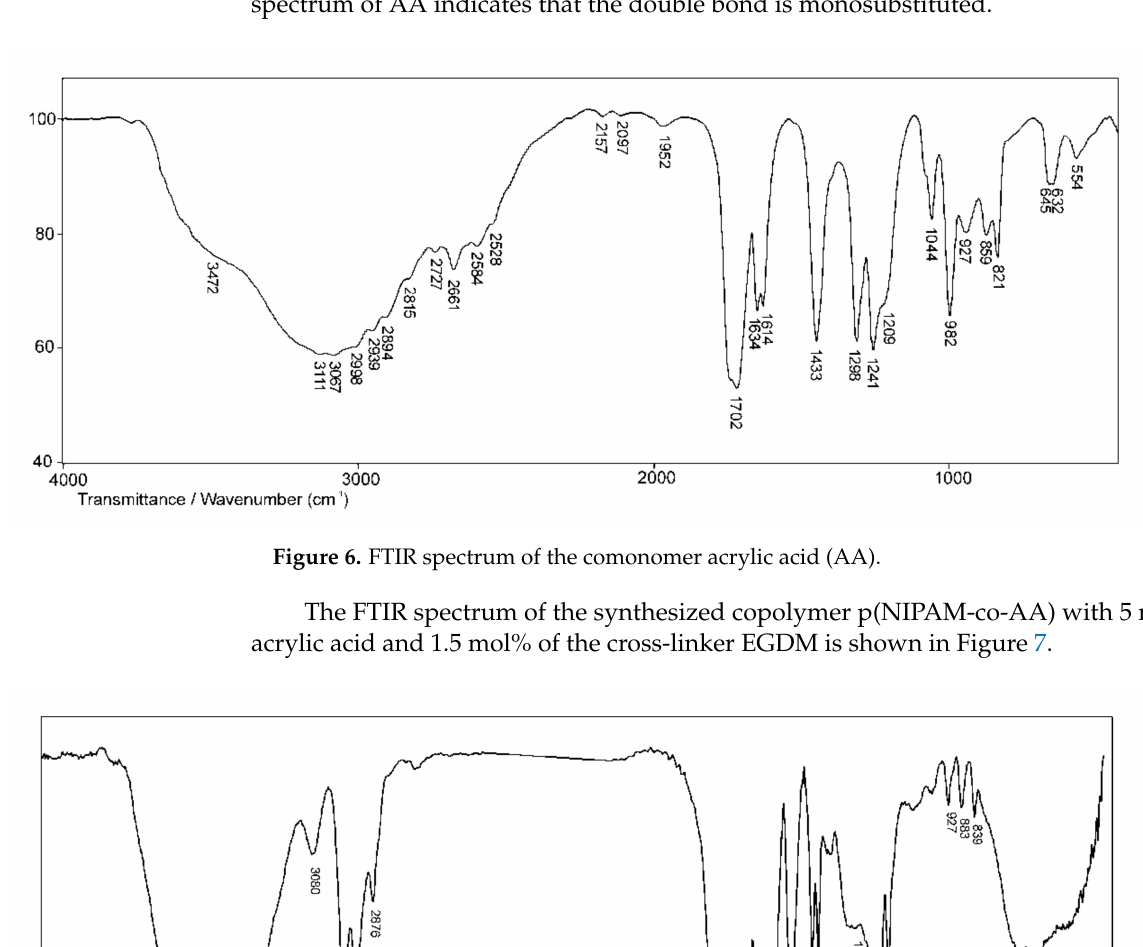
bond, ν (C–O), coupled with in-plane deformation vibrations, δ (OH), give two bands in the spectrum of AA with maxima at 1433 and 1241 cm − 1 , and confirm the presence of the COOH group. The characteristic bands originating from out-of-plane bending vibrations of the vinyl C–H bond appear at 1044 and 982 cm − 1 . The presence of these bands in the spectrum of AA indicates that the double bond is monosubstituted.